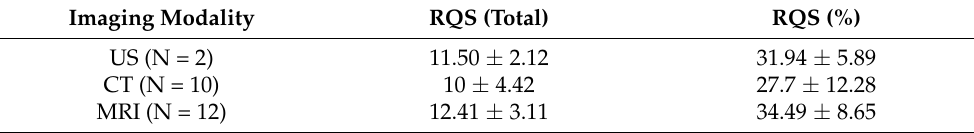
Table 4. Radiomics quality score of included studies categorized according to imaging modality. Imaging Modality RQS